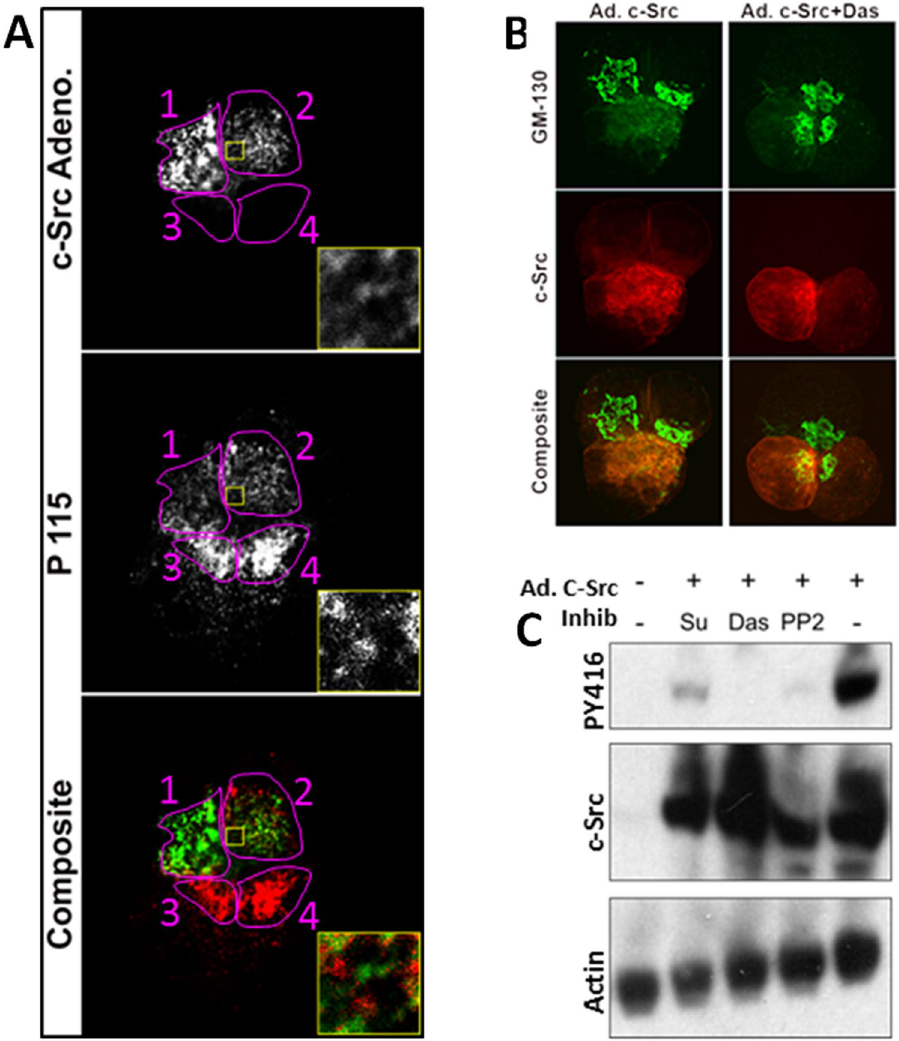
Figure 2. Effect of c-Src overexpression on Golgi morphology. ( A ) Primary mouse pancreatic acinar cells expressing c-Src adenovirus (Cells 1, 2) are shown in the top panel. The effect of this on the Golgi marker p115 is shown in the middle panel and composites in the lower panel. Inset magnified areas showing the hollow unstained round areas containing zymogen granules and both c-Src and P115 are extending into the basal ER. ( B ) AR42J cells infected with c-Src adenovirus alone (left panel) or with the Src inhibitor Dasatinib (Das; 10 μ M) in the right panel. In Green is the golgi marker GM-130 (upper panel), red is staining for c-Src (middle panel), with the composite image shown in the lower panel. Note Src inhibition with Dasatinib prevents the extension of GM130 staining in the c-Src expressing cell. ( C ) Western blot of AR42J cell lysates overexpressing adenoviral c-Src blotted for active Src (PY416) upper panel, c-Src (middle panel) and loading control actin (lower panel) showing the effects of pharmacologic inhibition of Src with SU6656 (Su), Dasatinib (Das) and PP2 on Src